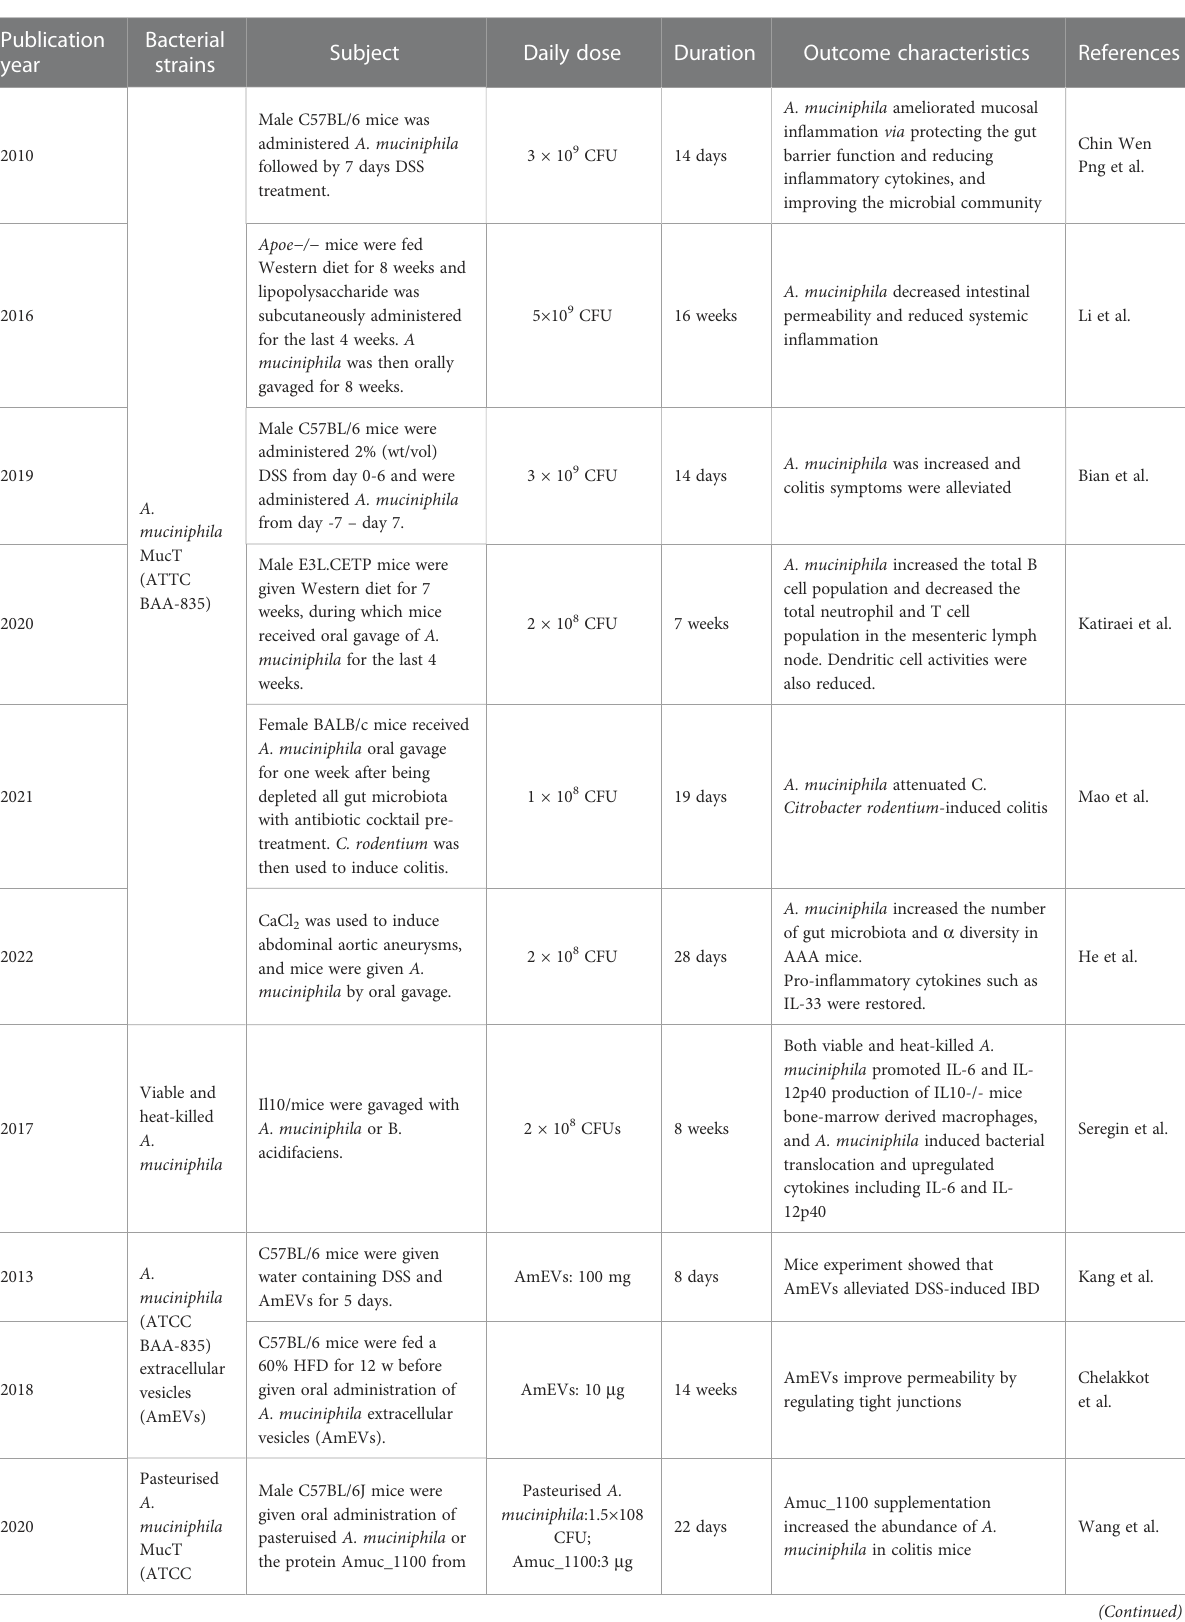
TABLE 3 Pre-clinical studies on the administration of the A. muciniphila and its components for protection against in fl ammatory bowel